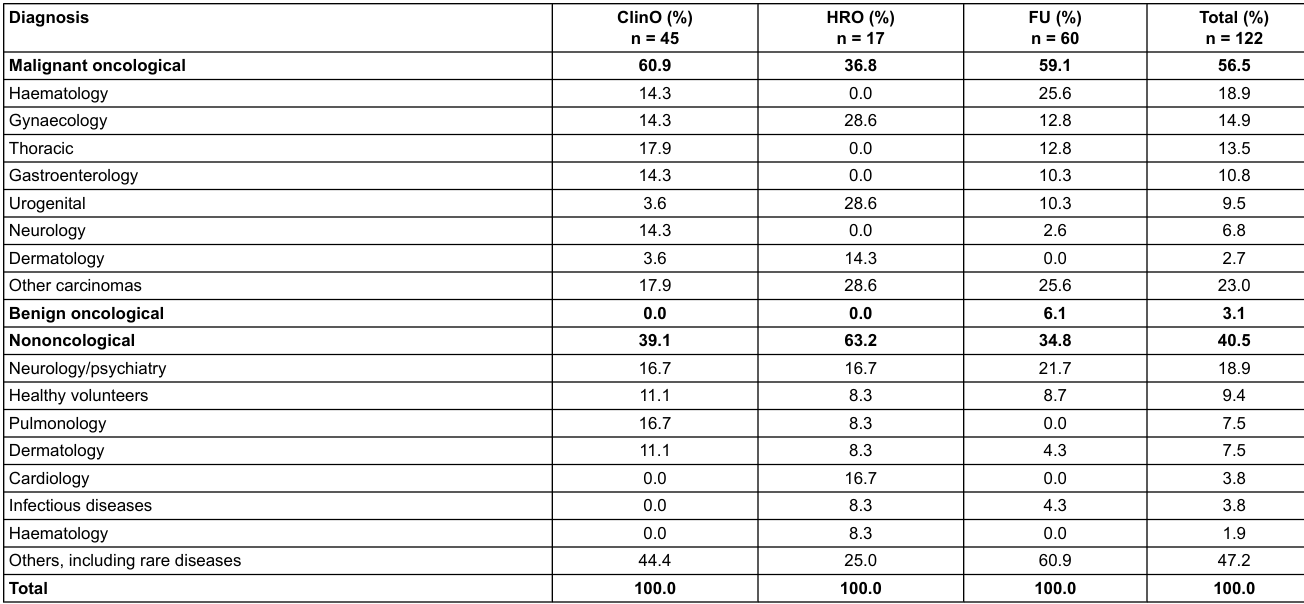
Table 1: Diagnostic categories of oncological versus nononcological